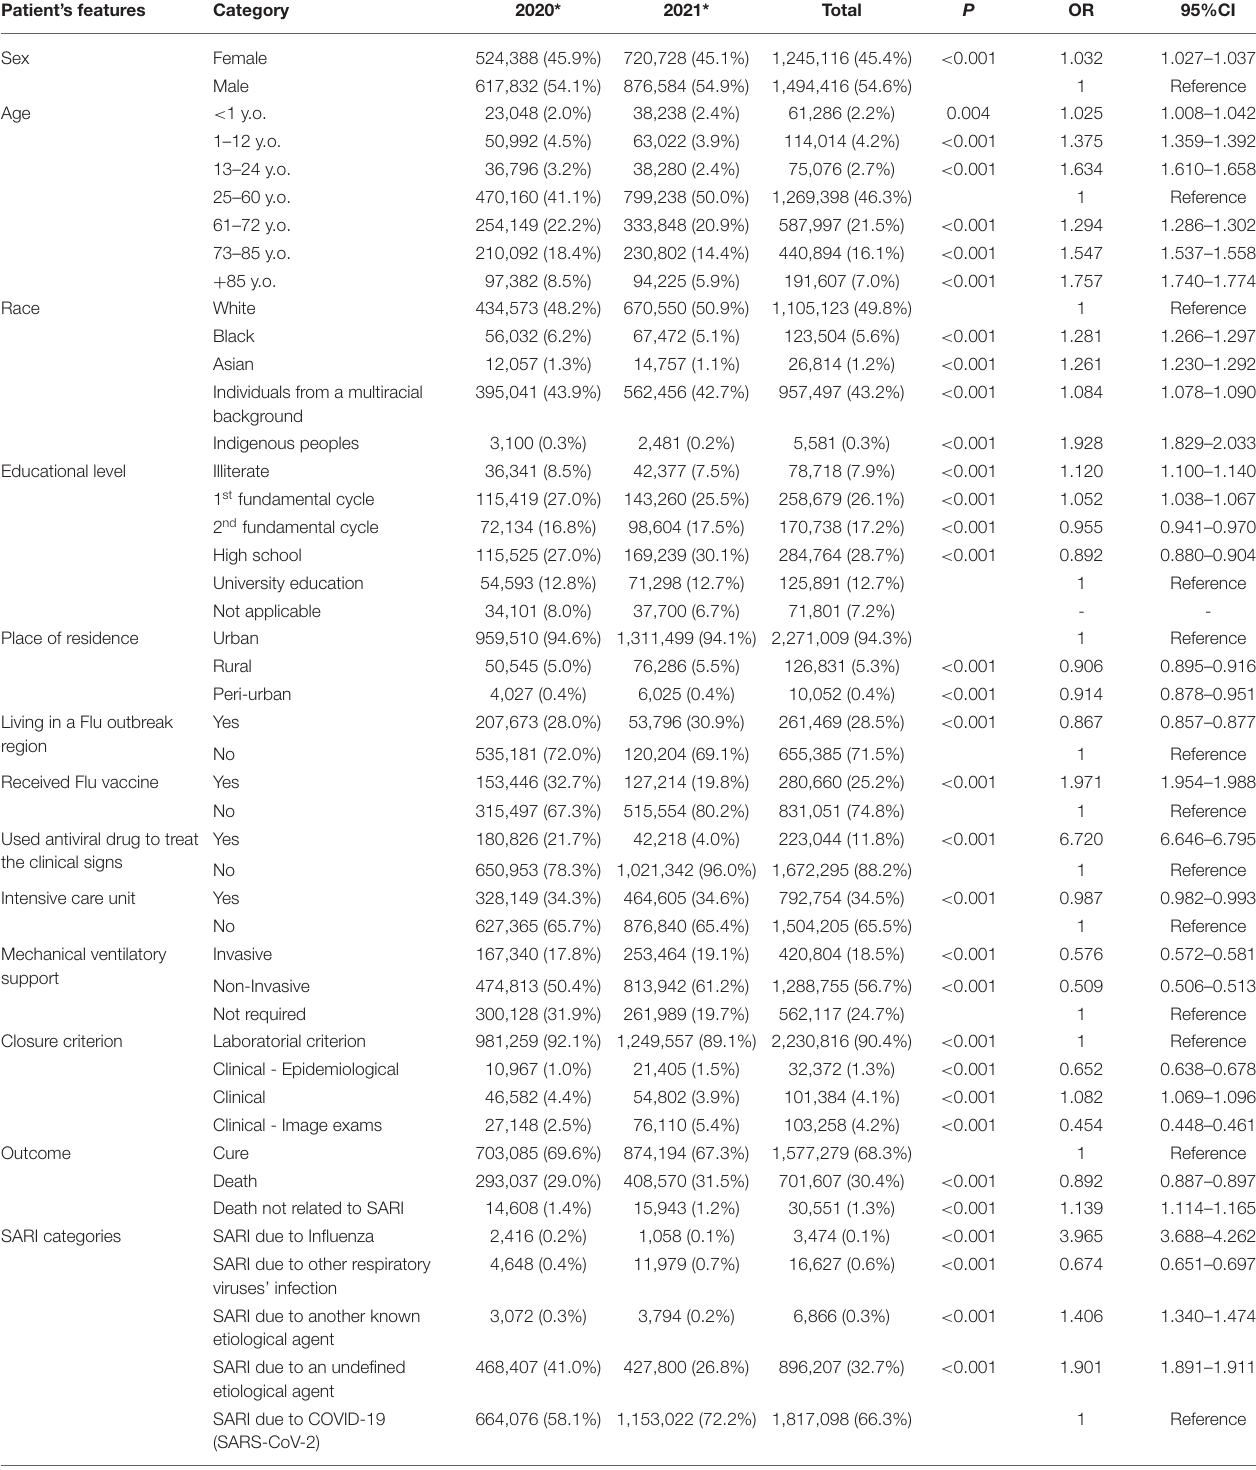
TABLE 6 | Association between features of the hospitalized patients due to severe acute respiratory infection (SARI) in Brazil during the Coronavirus Disease (COVID)-19 pandemic according to the collection period. Patient’s